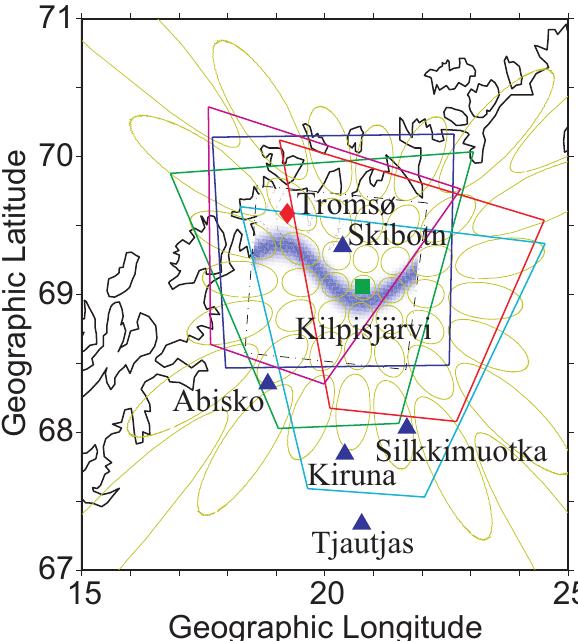
Fig. 1. Location of stations used in this paper. The quadrangles cor- respond to the fields of view of the ALIS imagers mapped to 110km altitude and the ovals show − 3dB contour of the main beams of the IRIS at 90km. The square surrounded by a dashed line indicates the simulation region at 110km alitutde. Note that this figure shows one example of the fields of view for each instrument and is valid only for the calculation in this